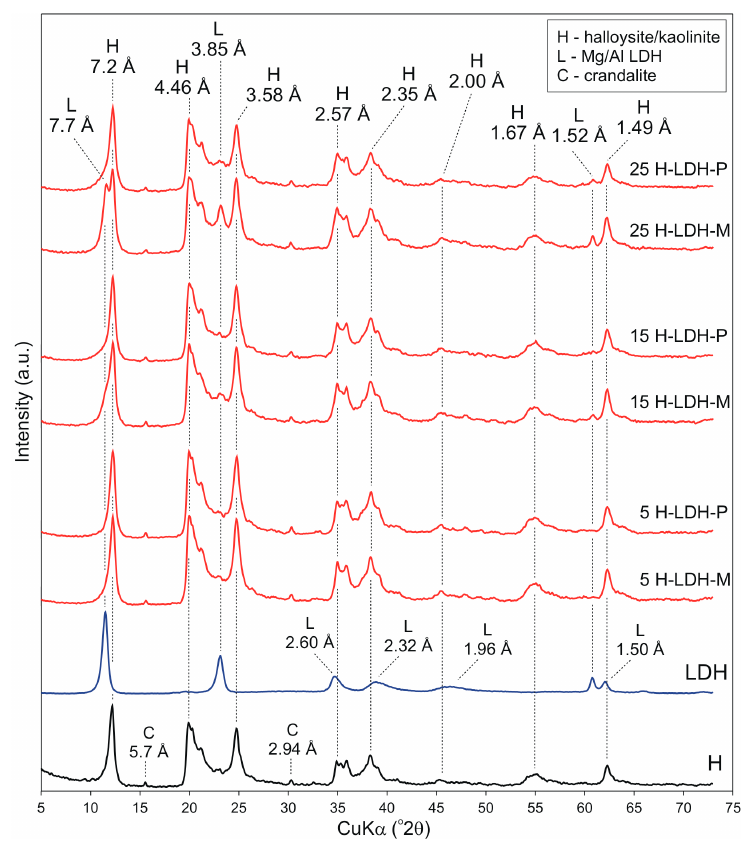
Figure 1. XRD patterns of halloysite sample (H), layered double hydroxide (LDH) and H-LDH materials.